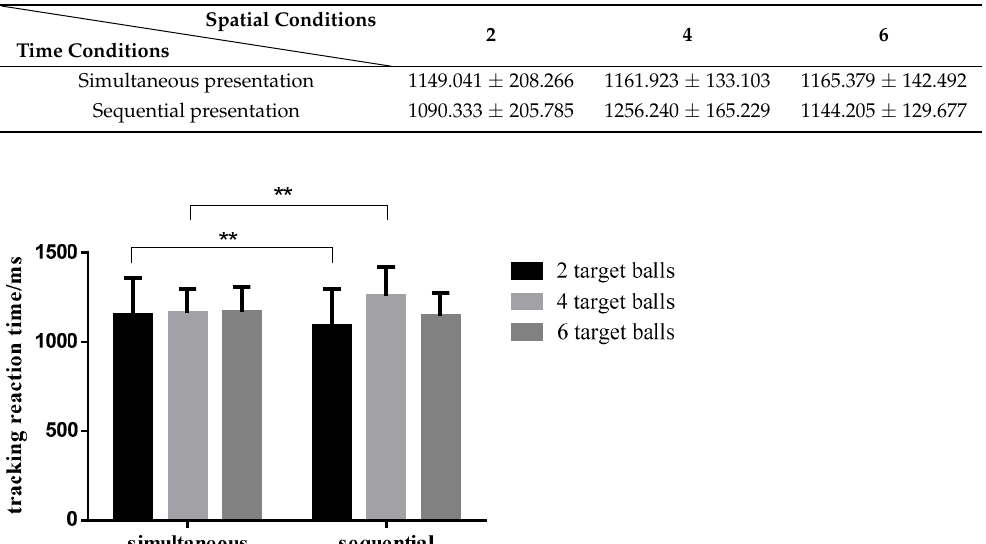
9 of 13 Figure 7. Comparison of the accuracy rate of different numbers of target balls in the simultaneous and sequential conditions. Note: *** indicates the significance level is p < 0.001.